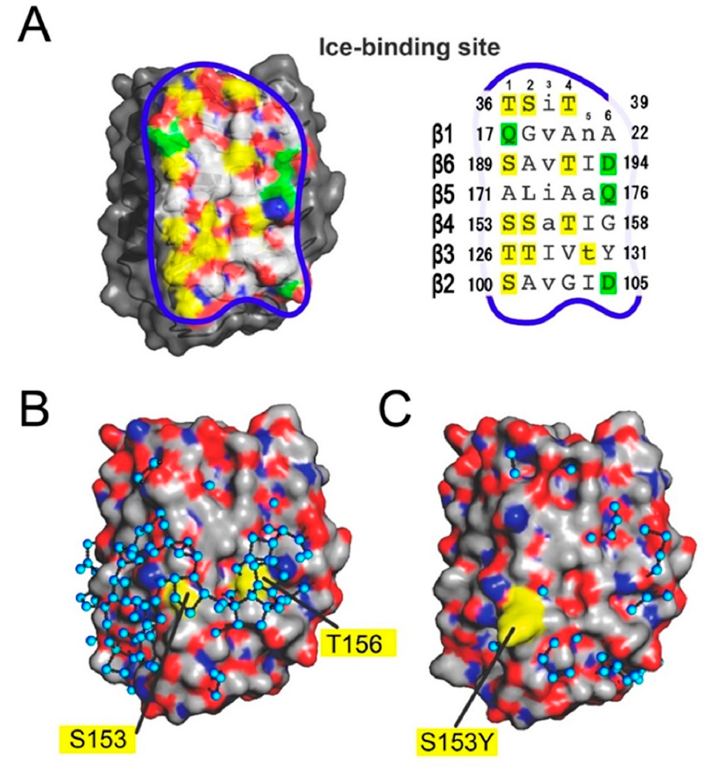
Figure 4. Surface models of the present determined structures of Anp IBP (7BWX.pdb) and its mutant (7BWY.pdb). ( A ) An ice-binding site (IBS) constructed on the B-face of Anp IBP (wild-type) whose area is indicated by a blue line. The capitals in columns 1, 2, 4, and 6 represent the outward-pointing residues, mostly Thr and Ser (yellow). The small characters in columns 3 and 5 are inward-pointing residues, mostly hydrophobic residues. The polar residues are aligned in column 6 (green). ( B ) Surface model of wild-type Anp IBP in the same orientation as ( A ), where gray, red, and blue show the hydrophobic, positively charged, and negatively charged residues, respectively. The black rods connect the oxygen atoms of the hydration waters (cyan) proximal to each other within 3.5 Å, the maximum allowed distance for a hydrogen bond [47,48]. Many hydration water molecules are circled and organized into polygonal geometry on the IBS. ( C ) Surface model of the crystal structure of the S153Y mutant whose ice-binding ability was lowered. The polygonally arranged water molecules were not detected on the